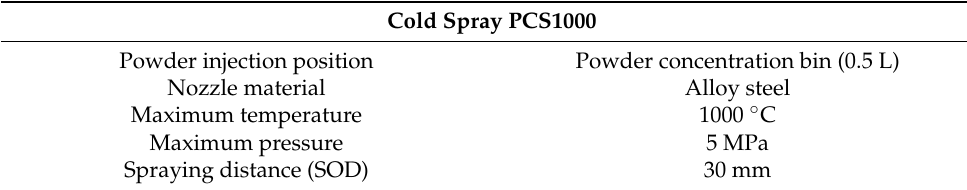
Table 3. Deposition parameters and characteristics of the CGDS process.